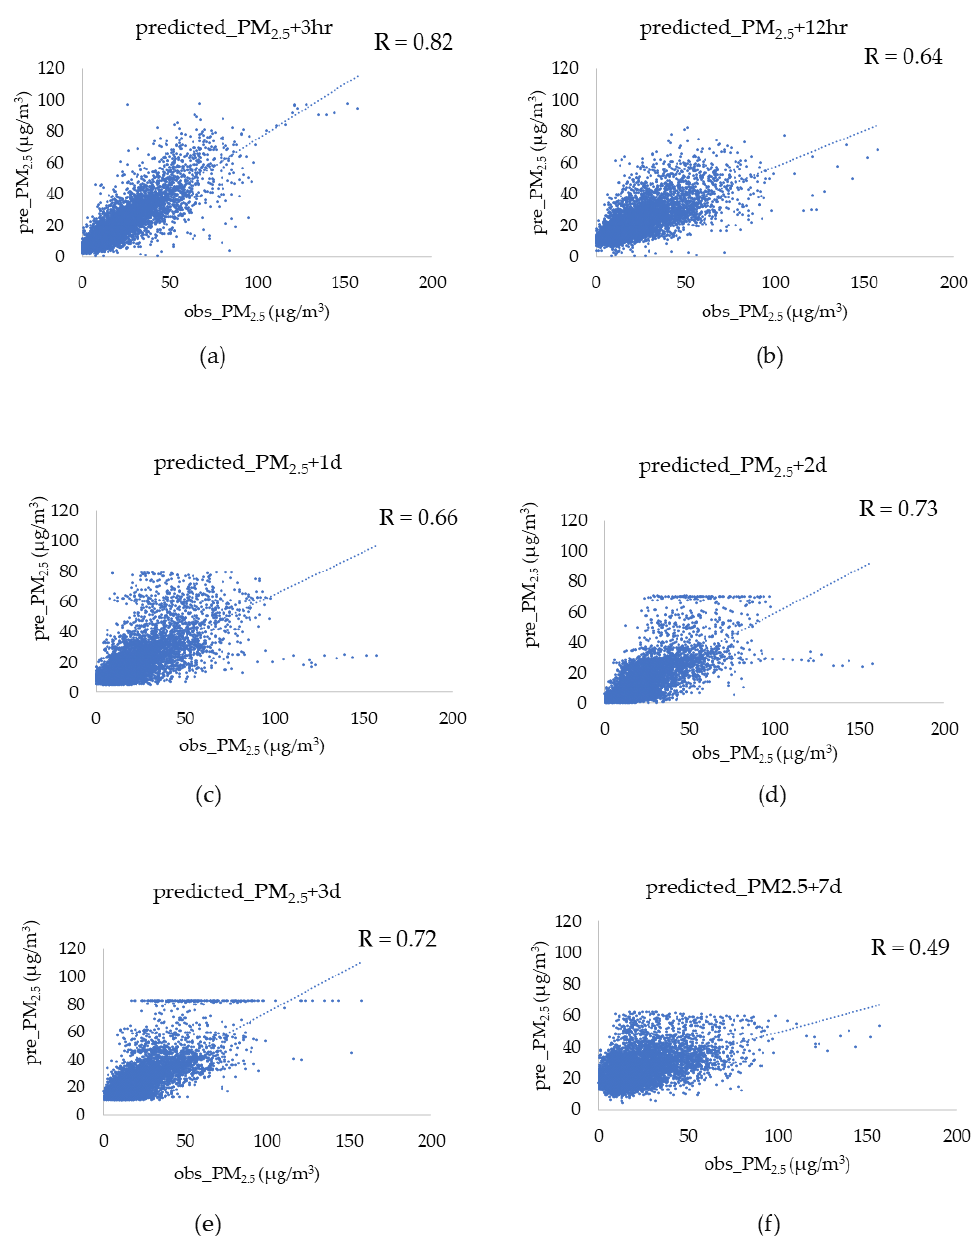
Figure 7. Quality of prediction (R) of PM 2.5 concentrations for up to 7 days using the multilayer perceptron approach compared with observed PM 2.5 data. Forward prediction for: (a) 3 h, (b) 12 h,